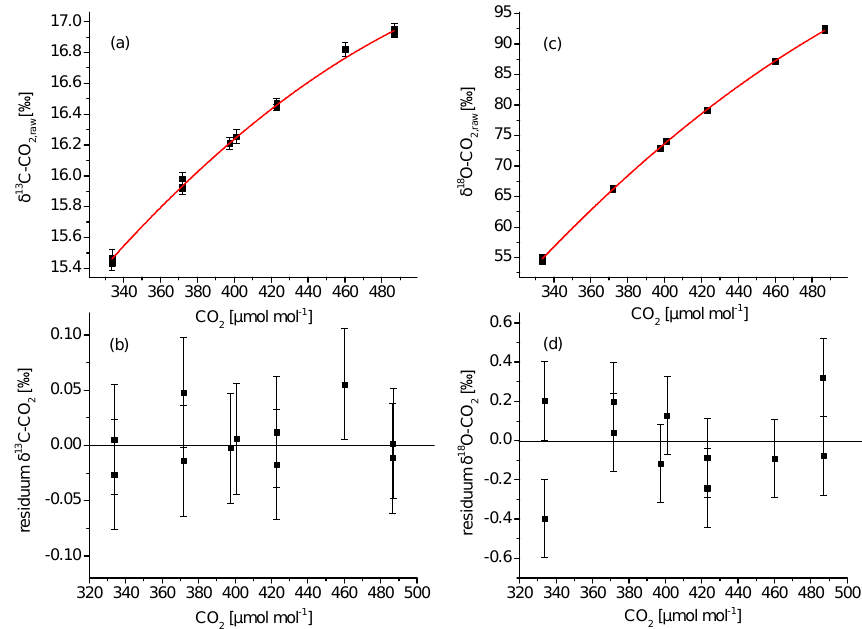
Figure 2. CO 2 dependence of raw δ 13 C-CO 2 and δ 18 O-CO 2 ( a and b ) and their residuals from the cubic fit ( b and d ). The experimental results shown here were obtained in August 2012; the same experiment was repeated in March 2014 and showed no significant difference to the earlier